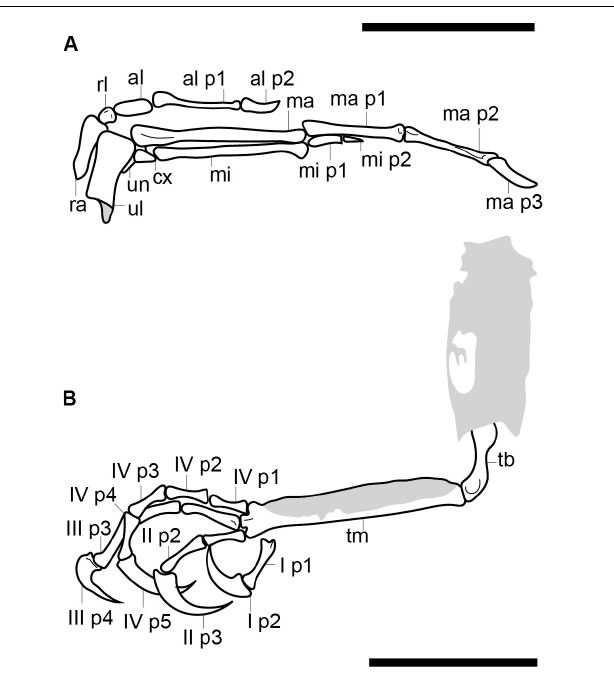
FIGURE 3 | Reconstruction of the right hand (A) and the left foot (B) . Scale bars equal 5 mm. Anatomical abbreviations not listed in the Figure 2 caption: al, alular metacarpal; ma, major metacarpal; mi, minor metacarpal; ma p1, major digit phalanx 1; mi p1, minor digit phalanx 1; minor digit phalanx 2; ra, radius; rl, radiale; ul, ulna; un,